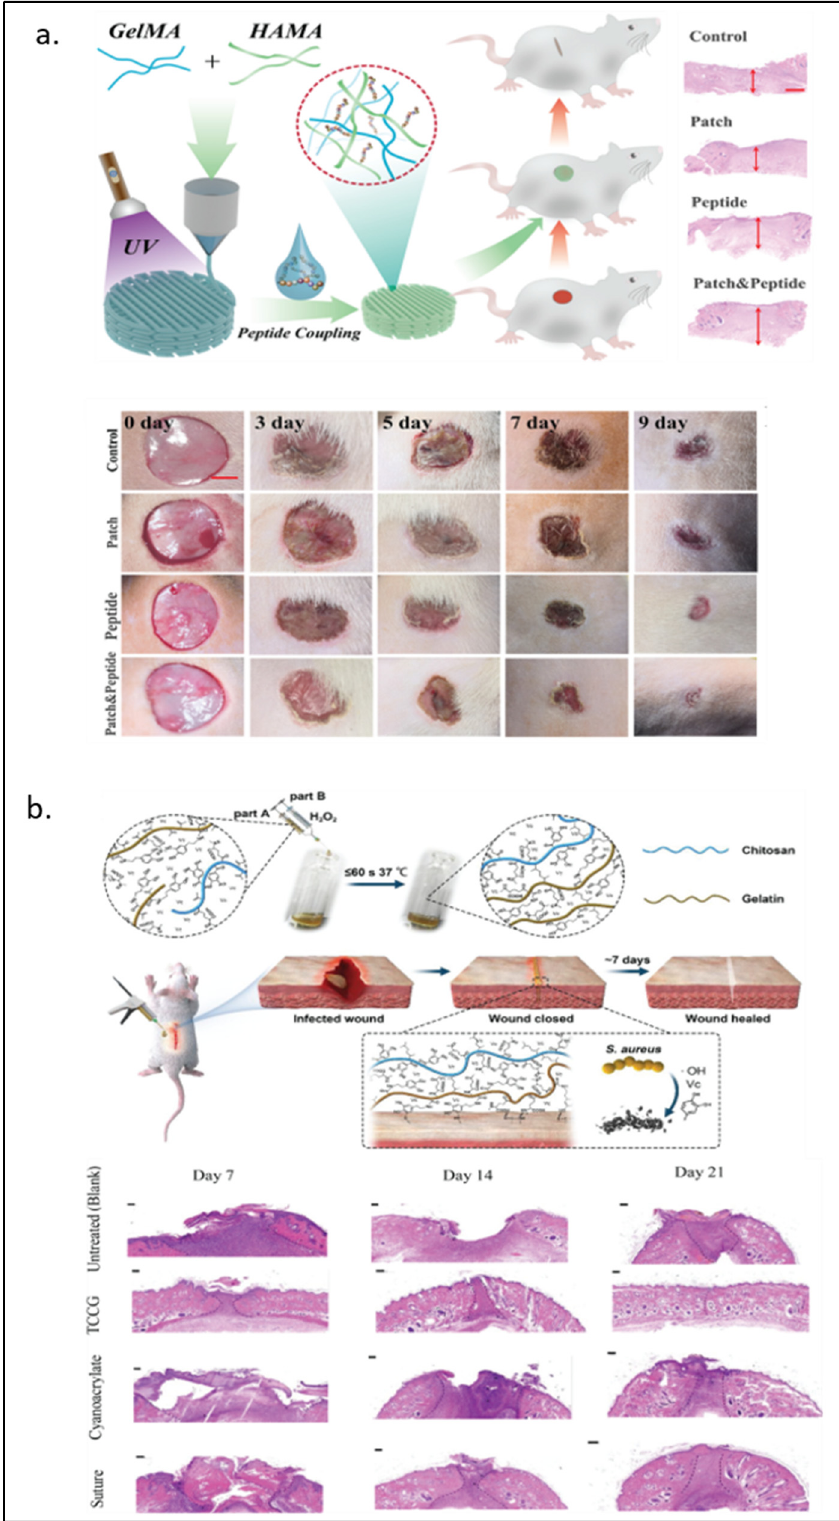
Figure 4. GelMA modified with naturally derived polymers. ( a ) Hyaluronic acid-modified GelMA for wound therapy from 0–9 days wounds and photographs of wound healing progress. ( b ) Schematic diagram of GelMA/chitosan wound adhesive doped with dopamine with antibacterial properties and H&E staining on days 7, 14, and 21 observed under an optical microscope. Reproduced (adapted) with permission from Ref. [35]. 2022 © Materials Today Bio, and Ref. [40]. 2020 © Carbohydrate polymers.